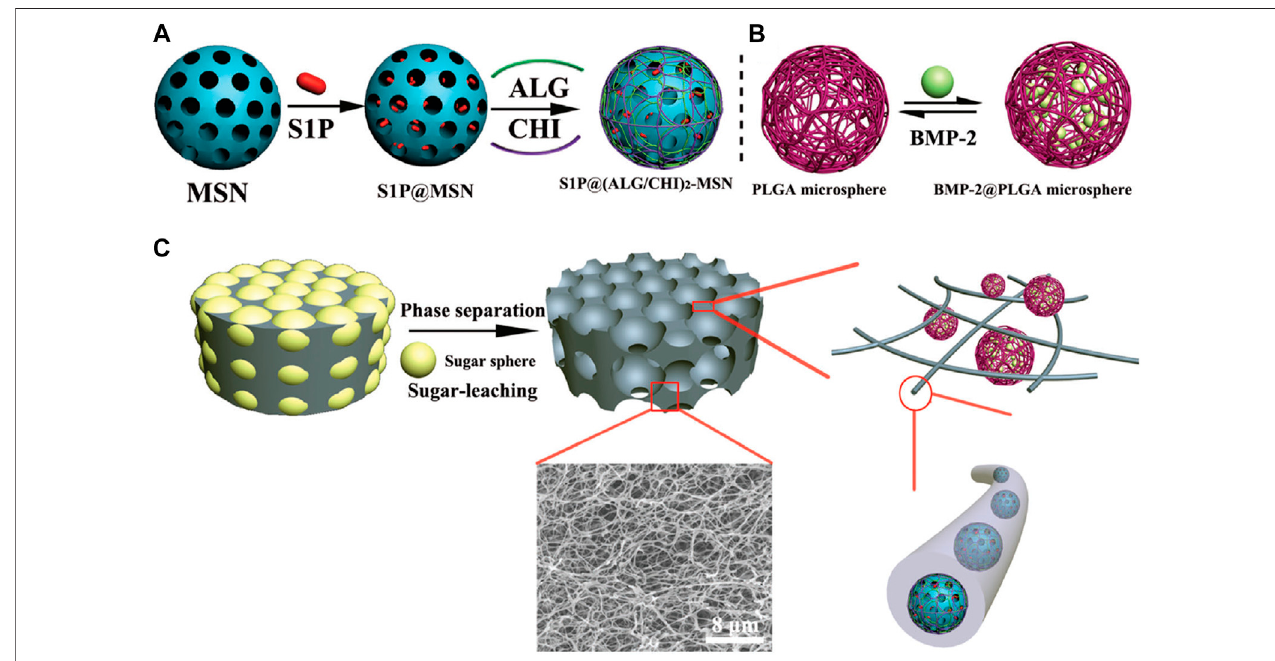
FIGURE9| Schematicpresentationoftheprocesstofabricatethebioactivefactorloadedcompositescaffold. (A) SchematicillustrationofthepreparationofS1P@ (ALG/CHI) 2 -MSNs; (B) the PLGA microspheres and BSA@PLGA microspheres; and (C) schematic illustration of the fabrication of the porous nano fi brous scaffold and the microstructure of the bioactive factor loaded composite scaffold. Reprinted with permission from Zhang et al. (2018). Copyright © The Royal Society of Chemistry 2018.